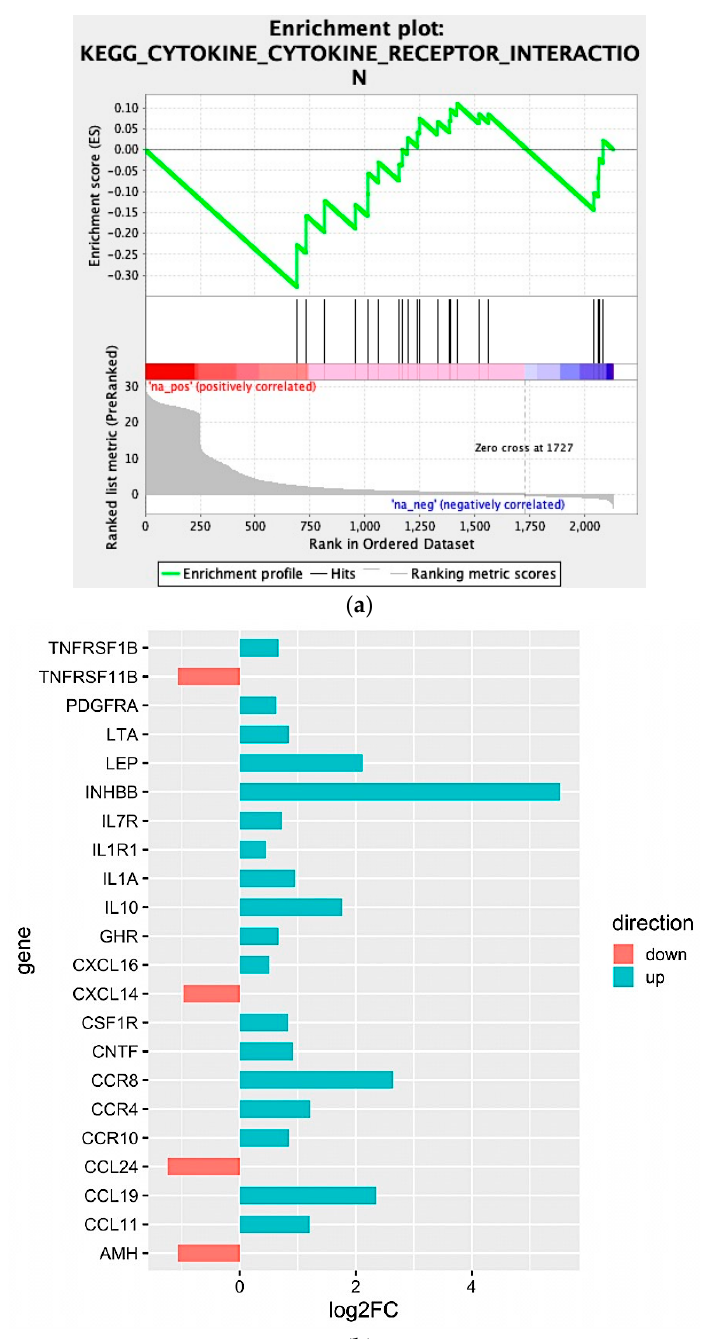
Figure 4. ( a ) Enrichment score graph of GSEA analysis. ( b ) Genes mostly contributing to the enrichment of “KEGG_CYTOKINE_CYTOKINE_RECEPTOR_INTERACTION” and their log2fold- change